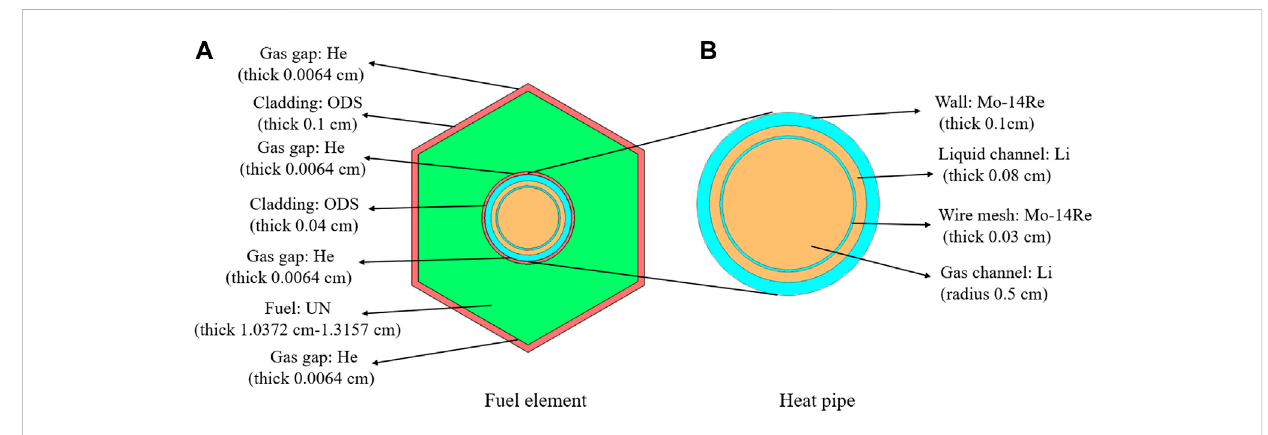
FIGURE 2 Cross-sections of the fuel element (A) and heat pipe (B)